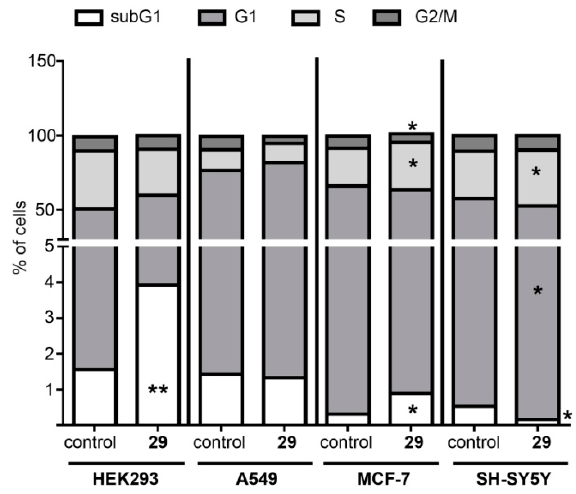
Figure 2. Cell cycle progression of HEK293, A549, MCF-7, and SHSY5Y cells upon compound 29 treatment. Data are expressed as mean ± S.E.M from three experiments, performed in triplicate. *— p ˂ 0.05 vs. corresponding control (untreated) cells (Wilcoxon t -test); **— p ˂ 0.01 vs. corresponding control (untreated) cells (Wilcoxon t -test).